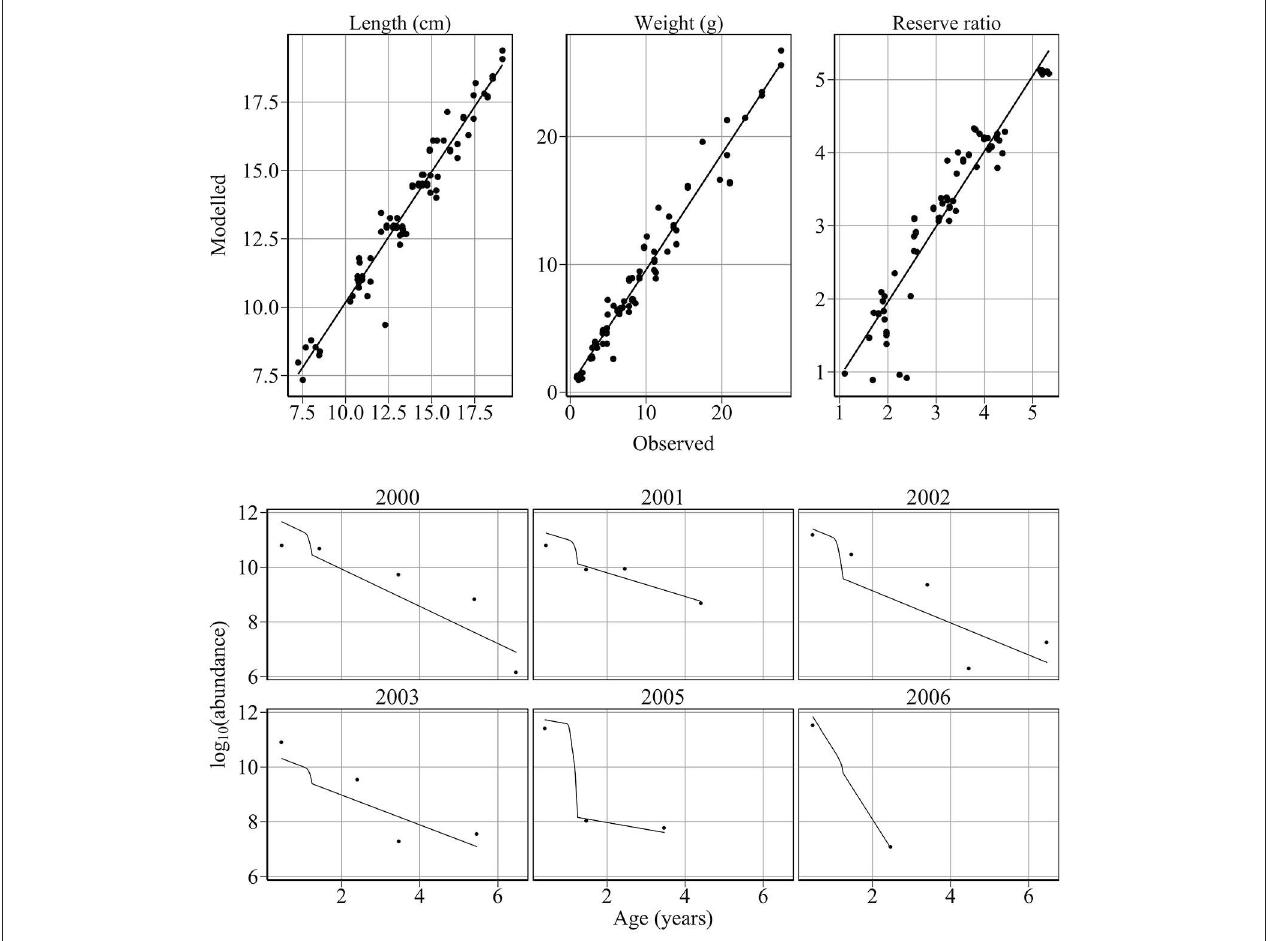
FIGURE 4 | Comparison of modeled and observed weight, length, reserve ratio and abundance. Upper panel: Comparison of modeled and observed weight, length, reserve ratio. Points represent observed mean values at survey dates. Black lines represent linear fits through the data. The model provides excellent fits to weight ( R 2 = 0.96, n = 83, intercept = − 0.224, slope = 1.063), length ( R 2 = 0.95, n = 83, intercept = 0.0292, slope = 0.996) and reserve ratio data ( R 2 = 0.91, n = 83, intercept = 0.394, slope = 0.88). Lower panel: comparison of modeled and observed abundance at age. Points represent observed abundance at age. Black lines represent modeled abundance at age. The model provides excellent fits to the 2000 ( R 2 = 0.71, p < 0.05, n = 5), 2001 ( R 2 = 0.87, p < 0.05), and 2005 ( R 2 = 0.996, p < 0.03, n = 3) cohorts and satisfactory fits to the 2002 ( R 2 = 0.67, p < 0.06), 2003 ( R 2 = 0.73, p < 0.1, n = 4), and 2006 ( n = 2) cohorts. The model provides an excellent fit to sandeel abundance at age over the study period ( R 2 = 0.84, p < 1e-9, n =